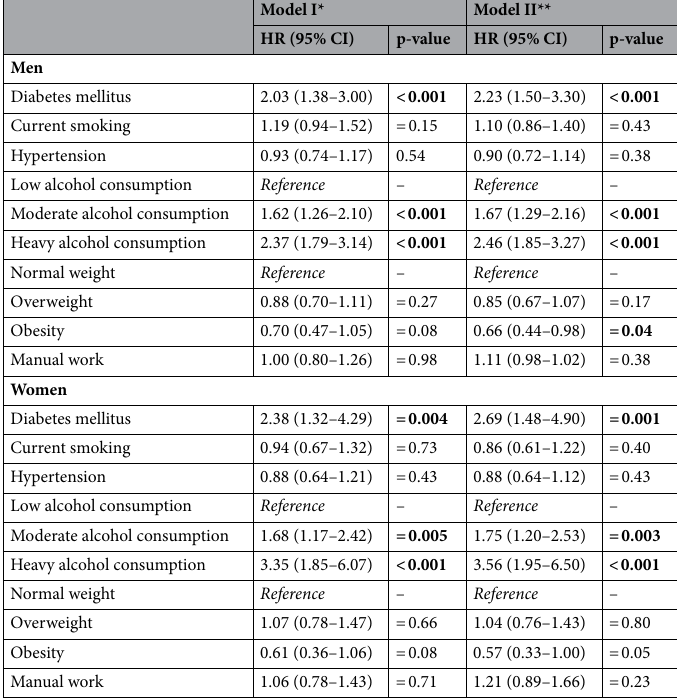
Table 3. Sex-stratified Cox regression models with HR for incident DD in relation covariates. CI confidence interval, DD Dupuytren’s disease, DM Diabetes Mellitus, HR Hazard Ratio. Bold values indicating p < 0.05. *Cox regression model including only age at study entry and respective variable. **Including age, DM, hypertension, smoking, alcohol consumption group, weight group, and manual